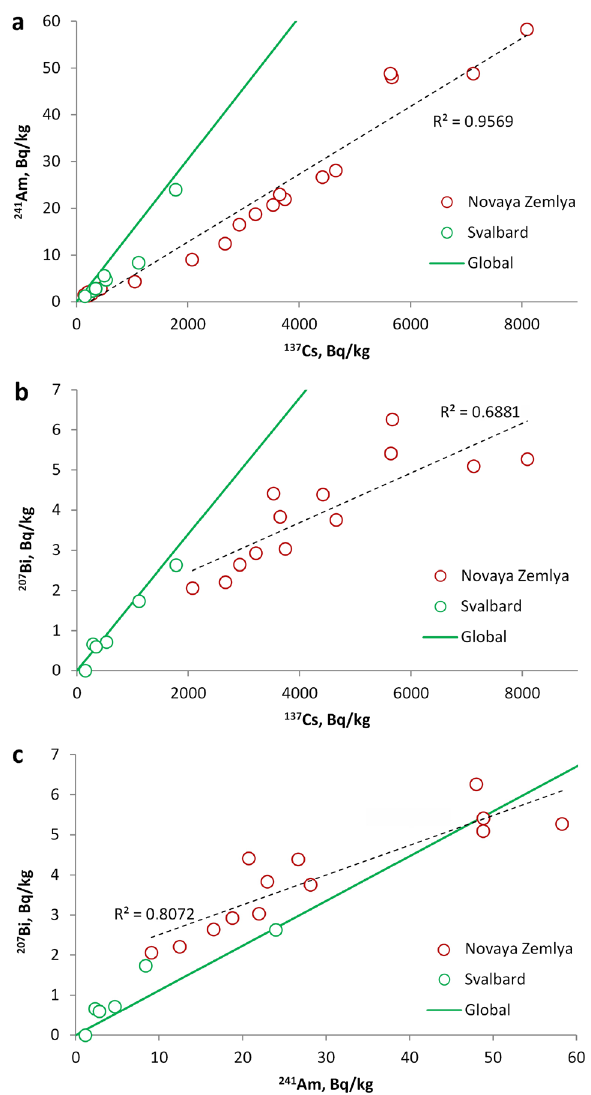
Figure 5. Radionuclides in cryoconite samples from Novaya Zemlya and Svalbard. ( a )— 241 Am/ 137 Cs ratio; ( b )— 207 Bi/ 137 Cs; ( c )— 207 Bi/ 241 Am. Black dashed line—corresponding trends. The solid black line corresponds to global fallout 38–41